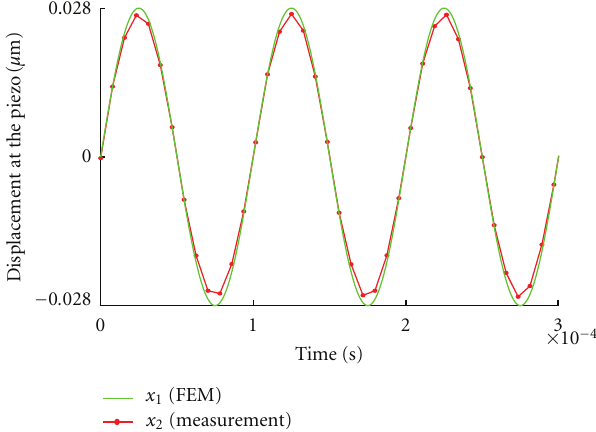
Figure 8: Comparison of simulated and experimental displacement data of the divided piezoceramic